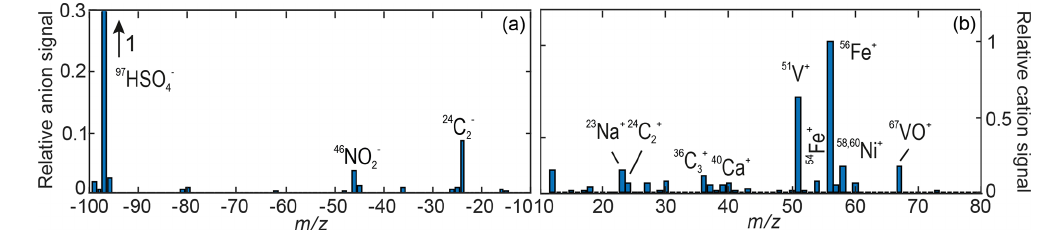
Figure 2. Average anion mass spectra (a) and cation mass spectra (b) of residual fuel emission particles. The other particle classes are shown in Fig. S1, and the top 300 particle clusters from ART-2a analysis are shown in Figs. S5 and S6.